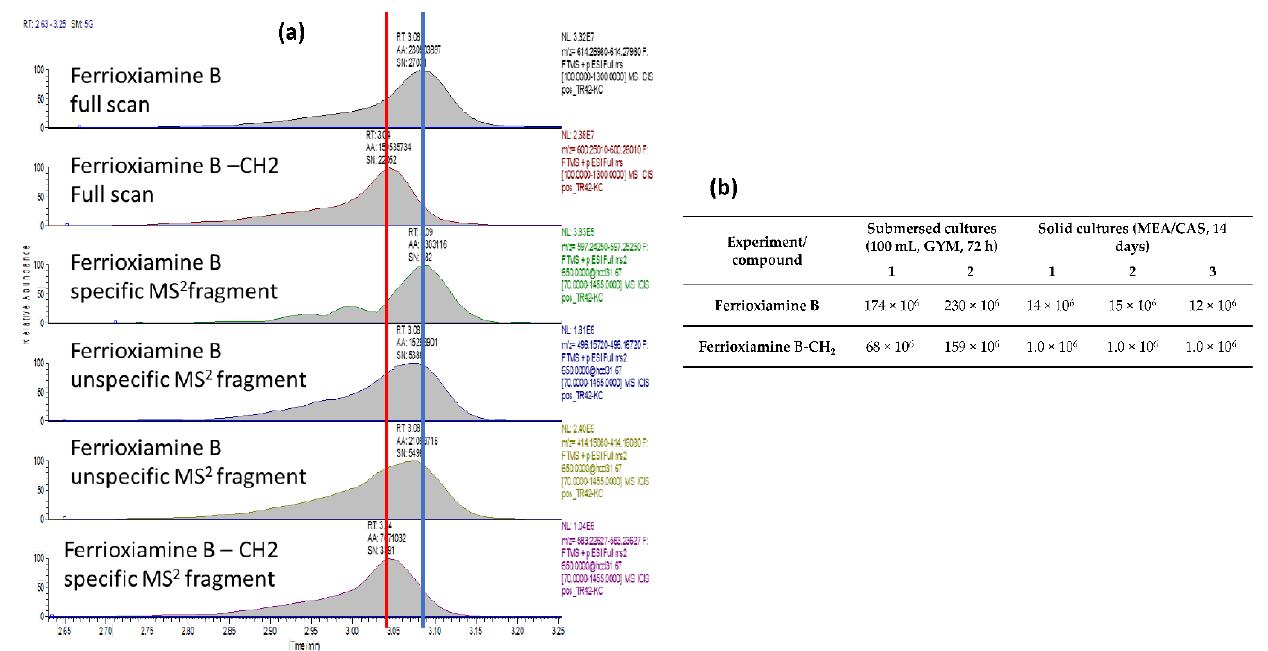
Figure 3. Ferrioxiamine B and its -CH 2 homologue detected in the extracts from the submersed cultures (1 – 2) and from the solid cultures (1 – 3). ( a ) Extracted XIC chromatograms of ferrioxiamine B and its -CH 2 homologue. ( b ) Semiquantitative evaluation of ferrioxiamine B and its homologue.